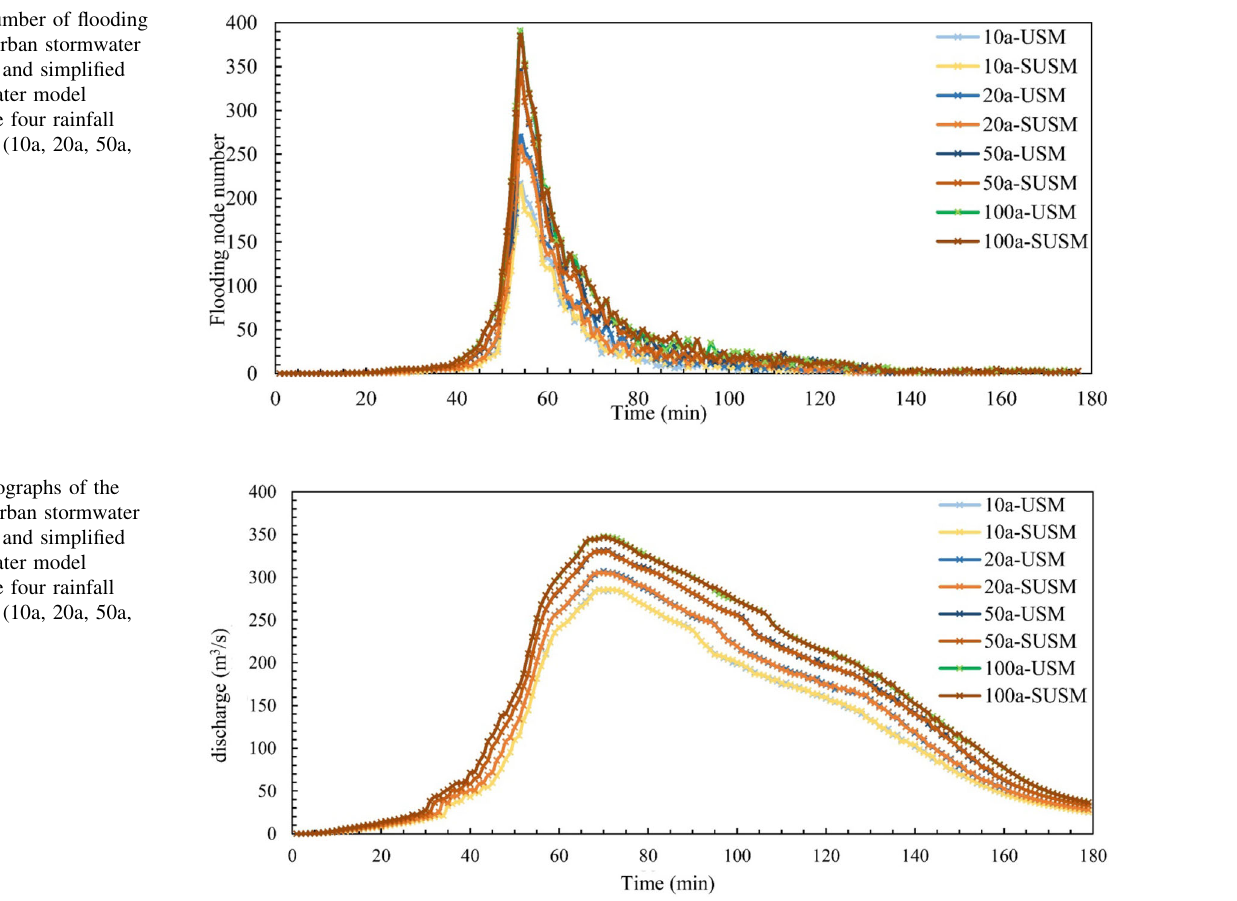
Fig. 9 The number of flooding nodes of the urban stormwater model (USM) and simplified urban stormwater model (SUSM) in the four rainfall return periods (10a, 20a, 50a, and 100a)